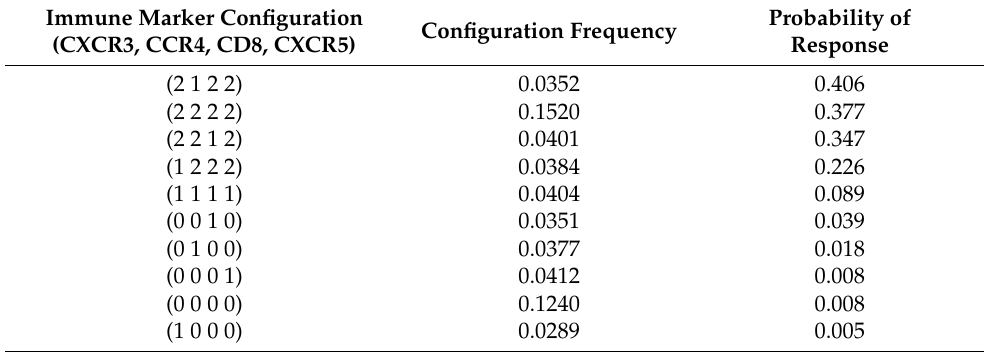
Table 3. The 10 most frequent predictive immune marker configurations (Adaptive FACS panel), in descending order of probability of response. First column shows predictive immune marker configurations obtained from the MN of the response status variable, four markers in total (CXCR3, CCR4, CD8, CXCR5). The values “0”, “1”, “2” in the first column indicate “low”, “medium” and “high” values after discretization. Second column shows configuration frequency; third column— probability of